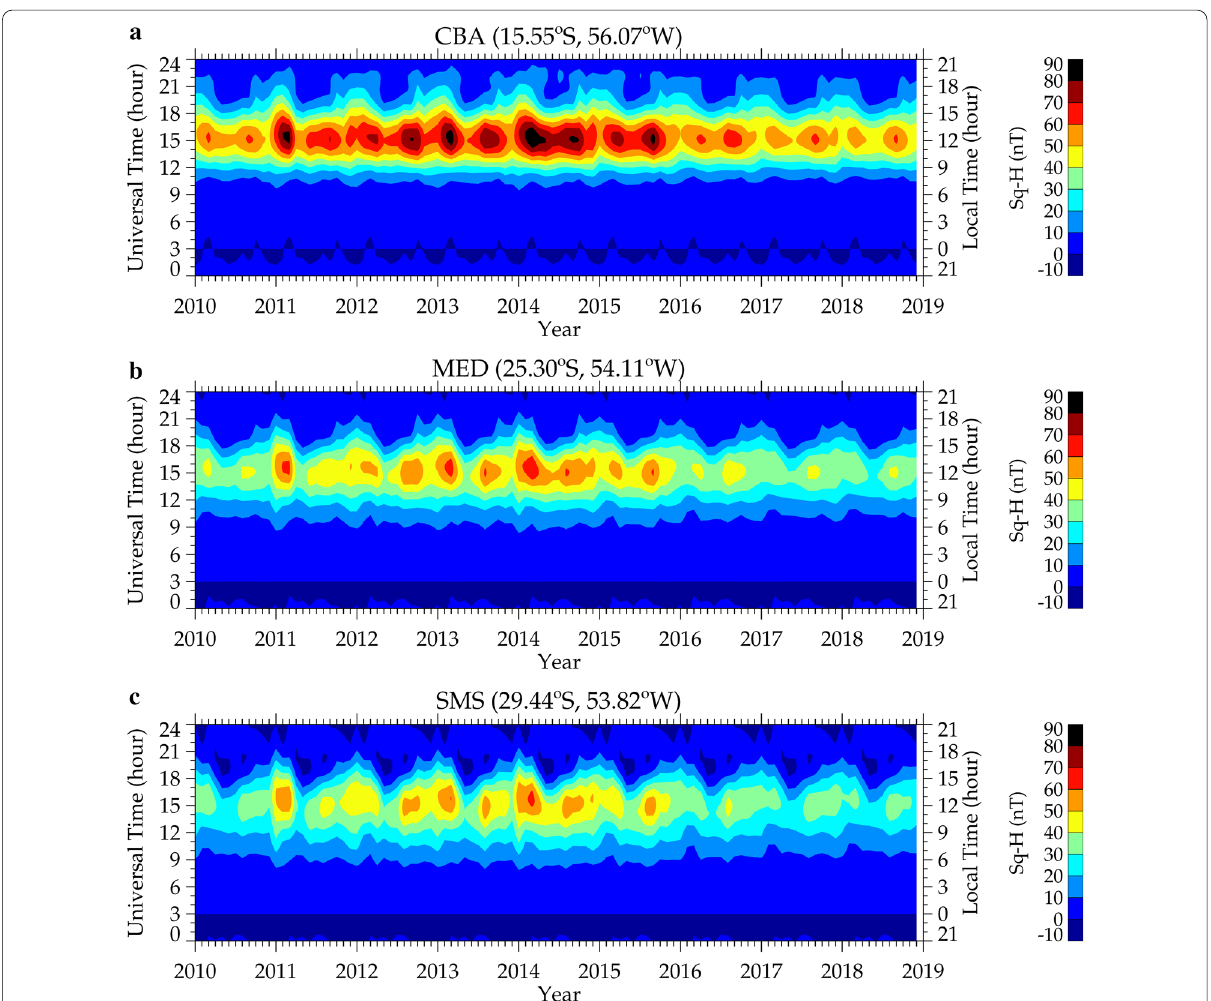
Fig. 4 Contour maps of the Sq-H field predictions for a CBA and c SMS, and estimations for b MED from January 2010 to December 2018